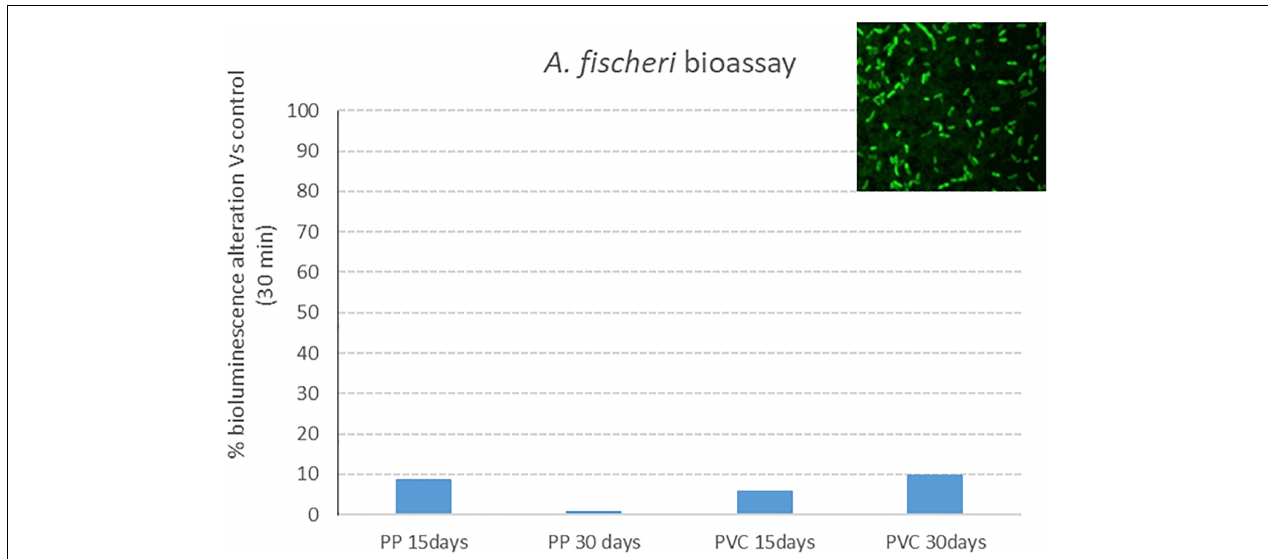
FIGURE 6 | Bacterial bioluminescence alteration: effect percentage (respect to control) after 30 min of exposure to PP 15 days, PP 30 days, PVC 15 days and PVC 30 days (samples after degradation with photocatalytic device).